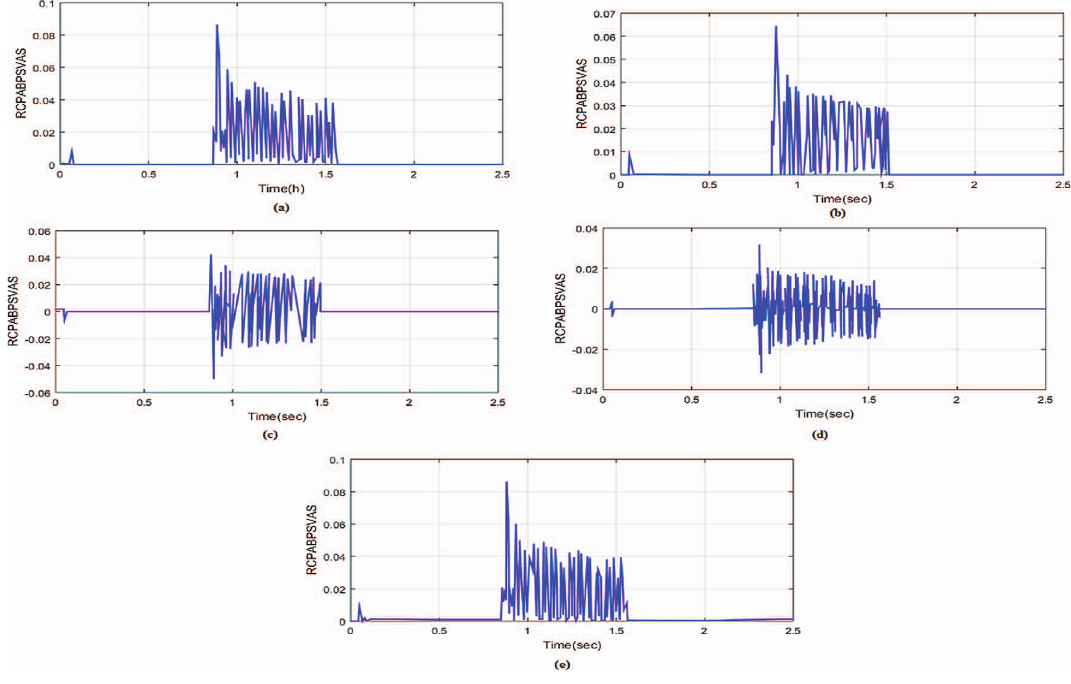
Fig. 12. System performance under overloading